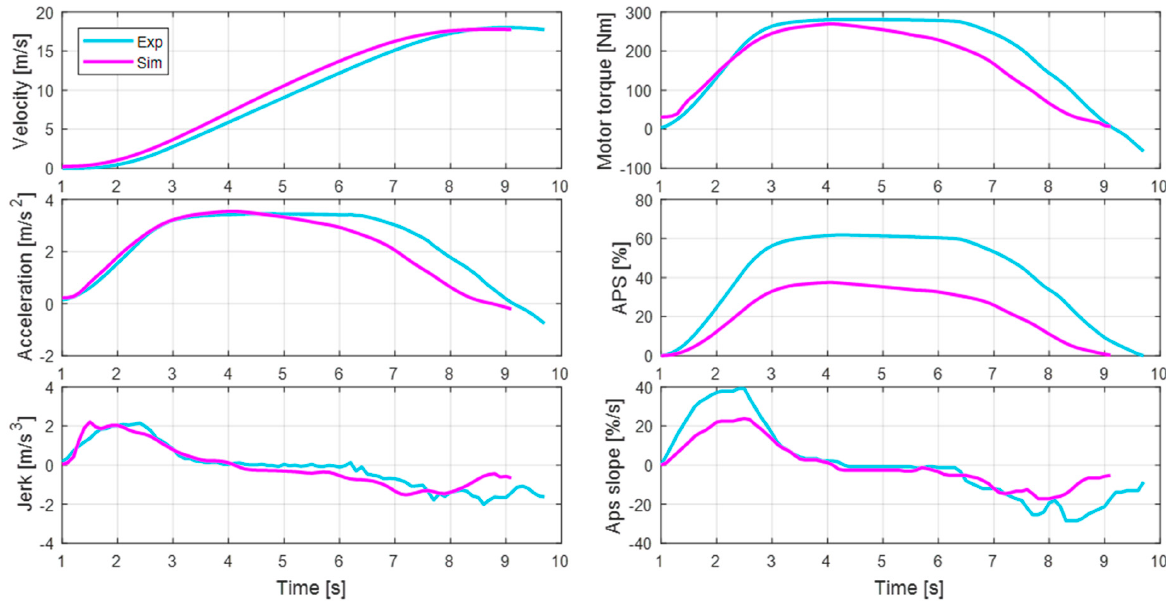
Figure 15. Comparison of acceleration behavior between the experiments and simulations of the 5th driver.